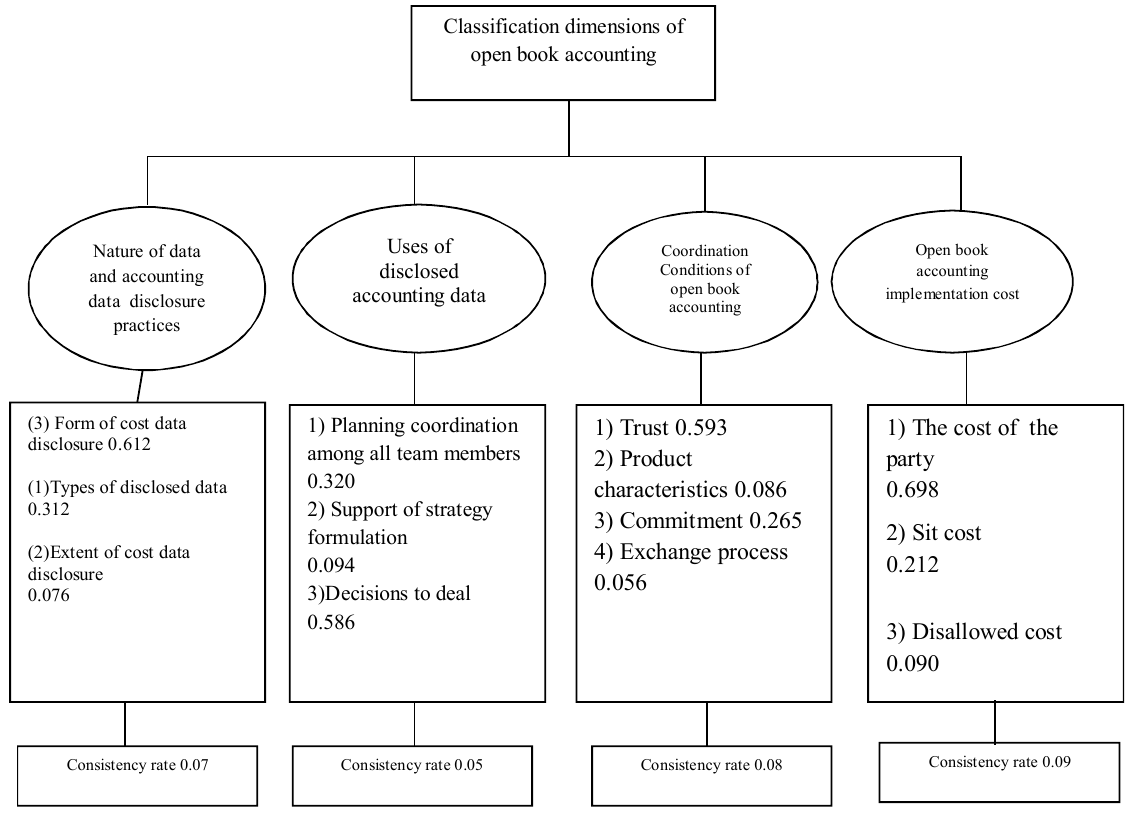
Fig. 3. Data analysis and